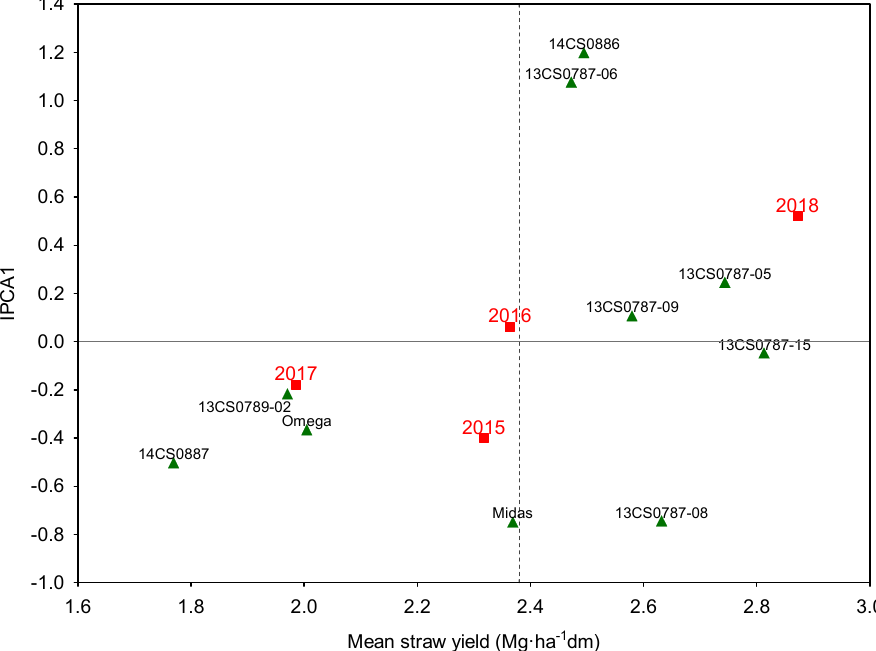
Figure 4. AMMI-1 biplot of the straw yield of 10 camelina genotypes (triangles) across four experimental years (2015–2018) with varied weather conditions (squares).